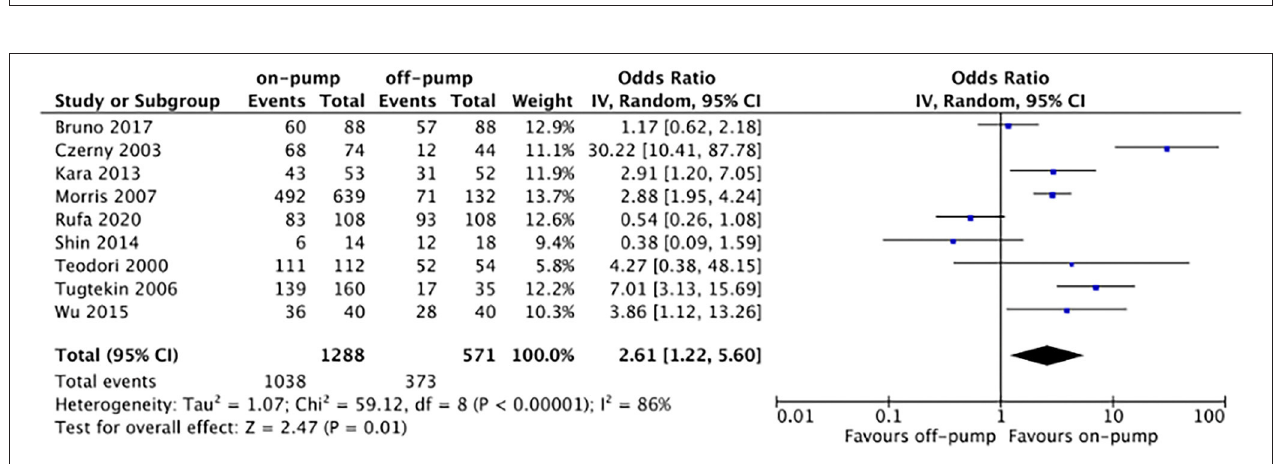
FIGURE 9 | Forest plot for long-term mortality.